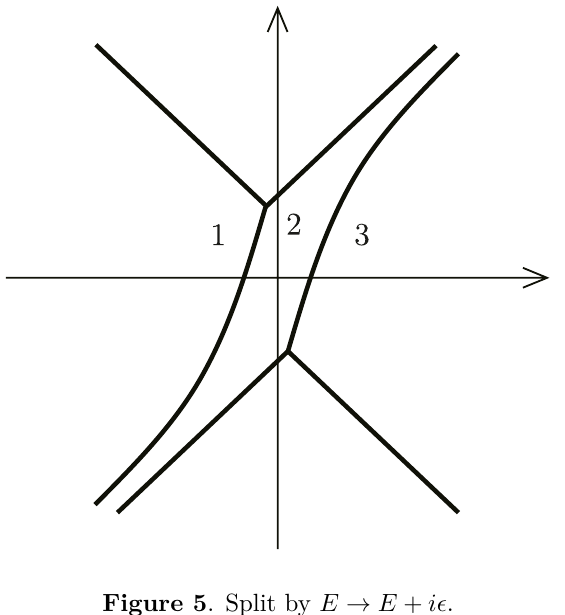
Figure 5 . Split by E → E + i(cid:15)